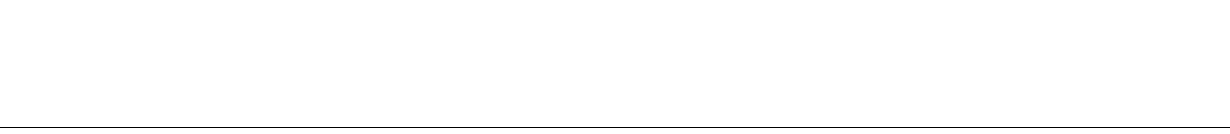
TABLE 3 | Comparison of the original-order RNN and the reduced-order RNN under Example 2.